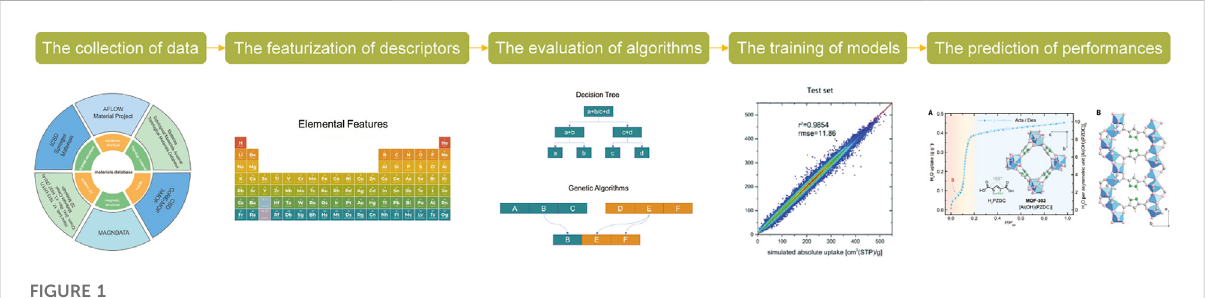
FIGURE 1 A diagrammatic illustration on the process of